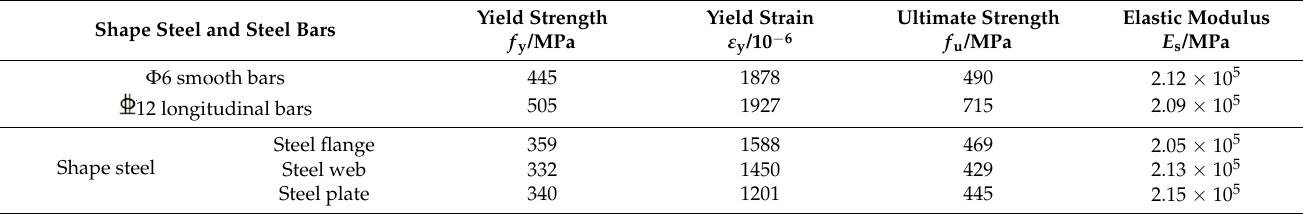
Table 1. Mechanical property of shape steel and steel bars.